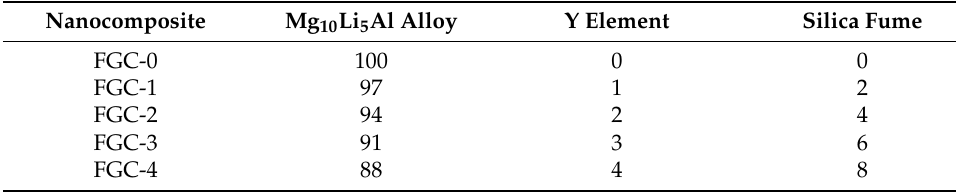
Table 2. Batch design of the investigated FGCs